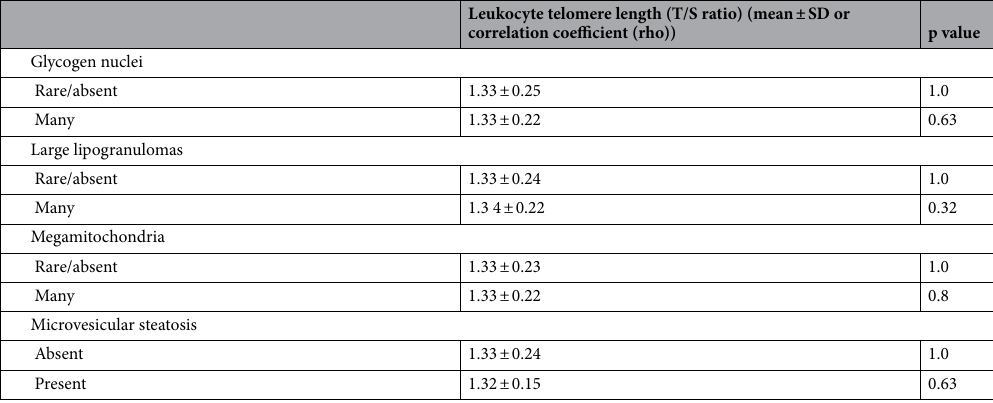
Table 3. Leukocyte telomere length in relation to baseline characteristics.